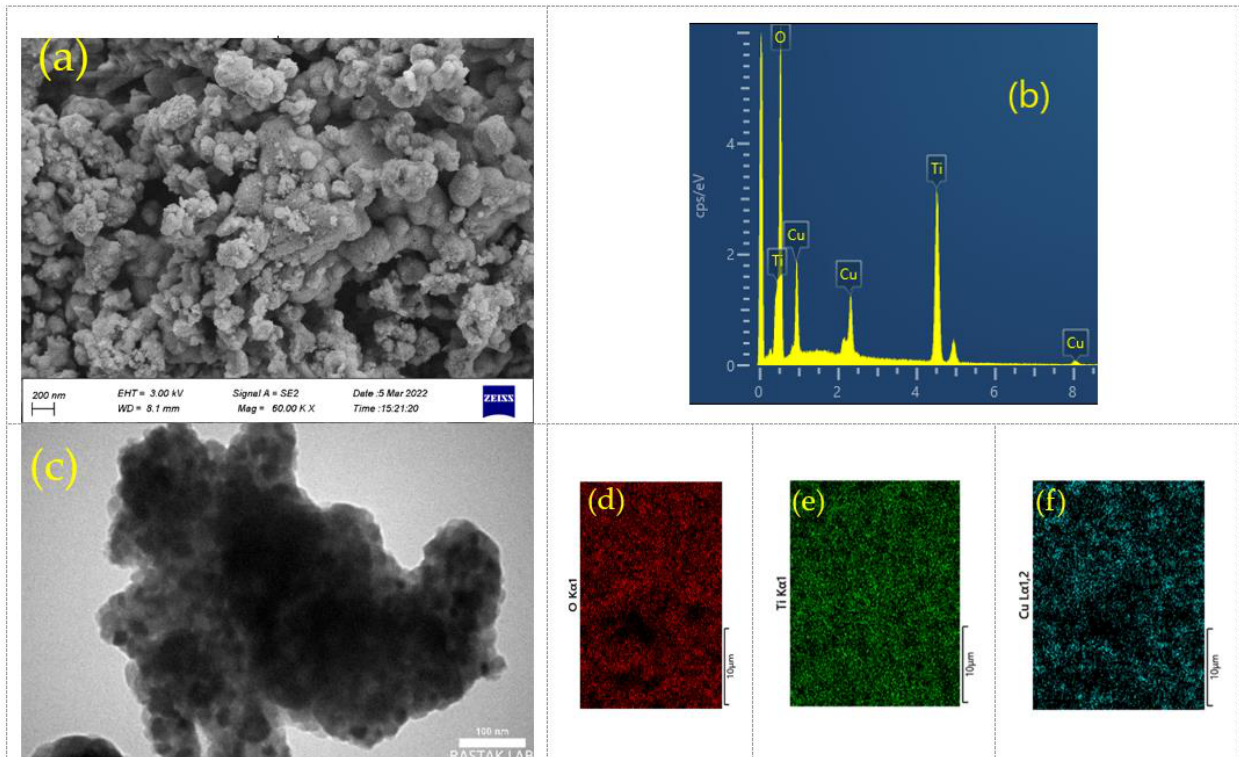
Figure 2. FE-SEM ( a ), EDX ( b ), TEM ( c ), and elemental mapping ( d – f ) of Cu-TiO 2 . BET analysis estimated the surface areas of prepared TiO 2 and Cu-TiO 2 to be 52.1 and 9.9 m 2 /g, respectively (Figure 3). It can be related to changes in the morphology and crystalline structure of the TiO 2 after doping with Cu [30]. This result agreed with Tasbihi et al. [34] and Bensouici et al. [22], who reported a decrease in the surface area of TiO 2 after doping with Cu. From the pore size distribution curve, Figure 3a,b (inset), and IUPAK categorization, both catalysts’ isotherms were observed to be type IV and mesoporous structures